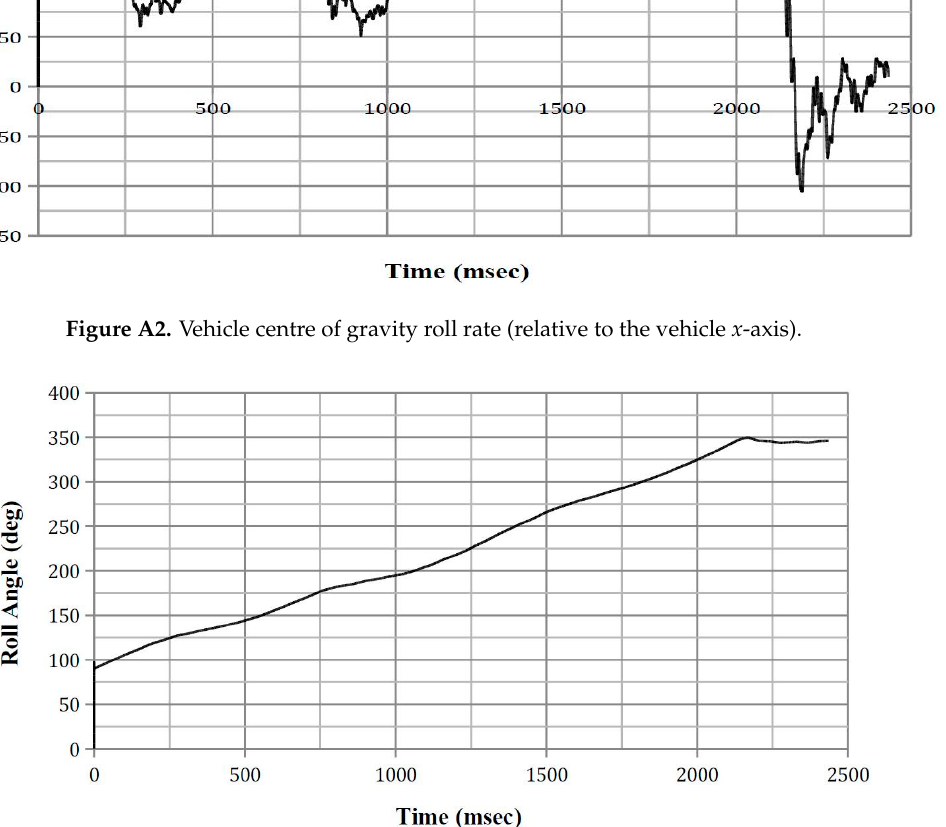
Figure A3. Vehicle centre of gravity roll angle (relative to the vehicle’s x-axis).